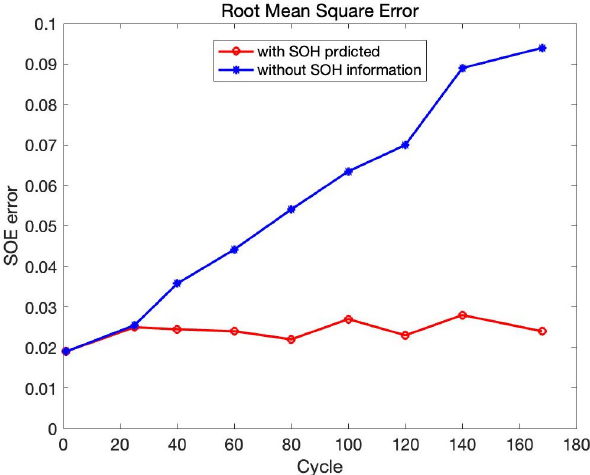
Figure 25. RMSE in